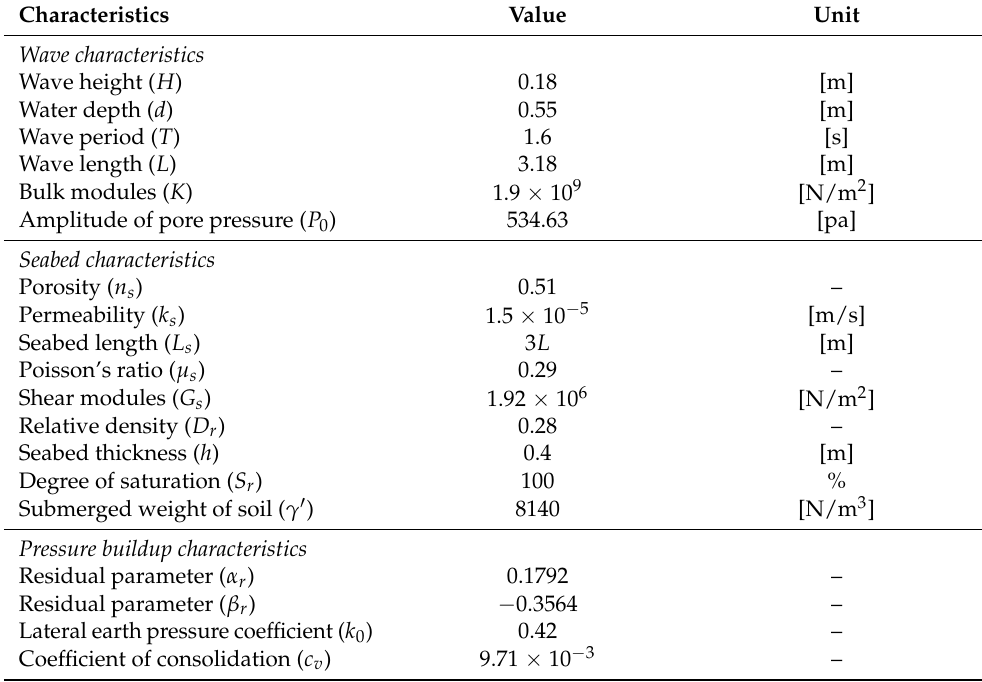
Table 1. Parameters for the first validation